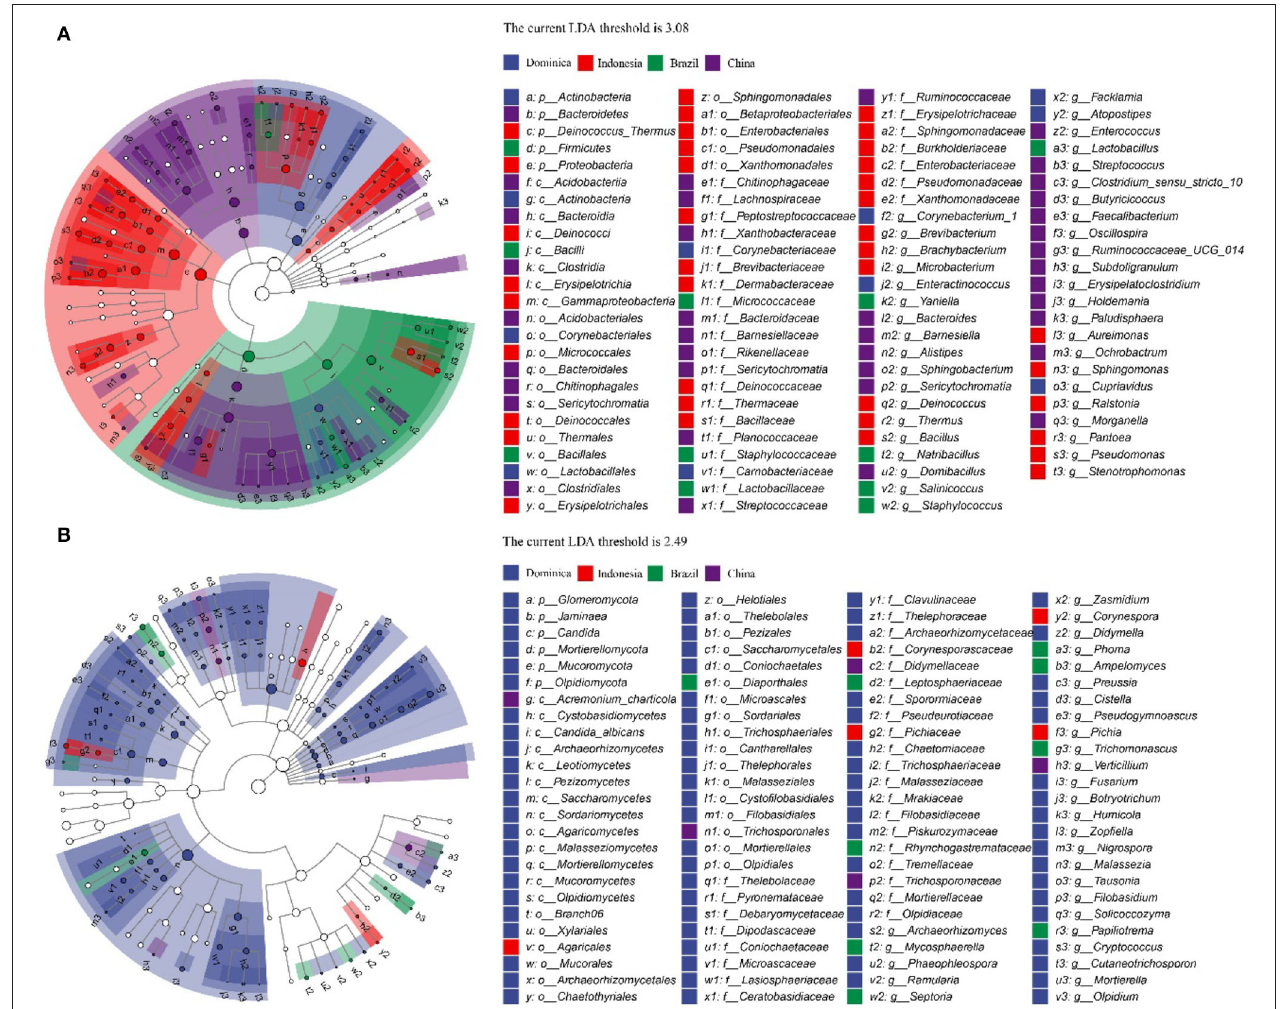
FIGURE 4 | Evolutionary branch map of the bacteria (A) and fungus (B) with significantly different in cigar tobacco leaves with different treatments.